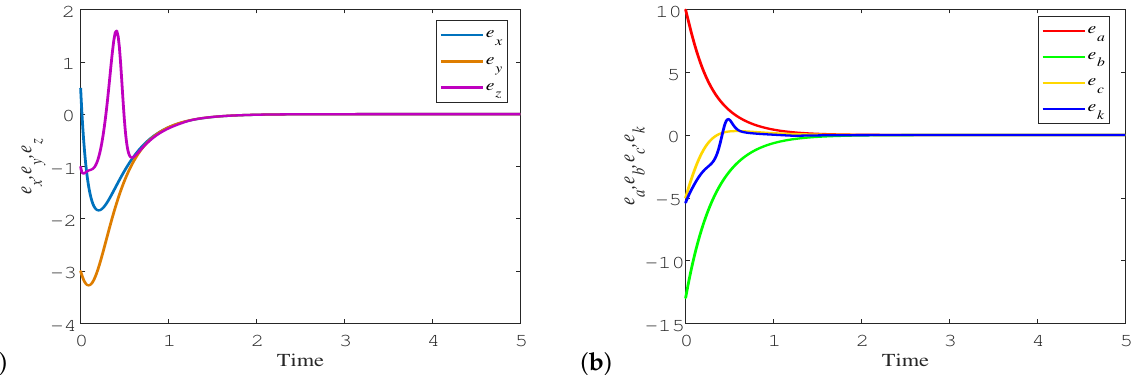
Figure 21. Time evolution of ( a ) synchronization errors e x , e y , and e z , and ( b ) parameter estimation errors e a , e b , e c , and e k